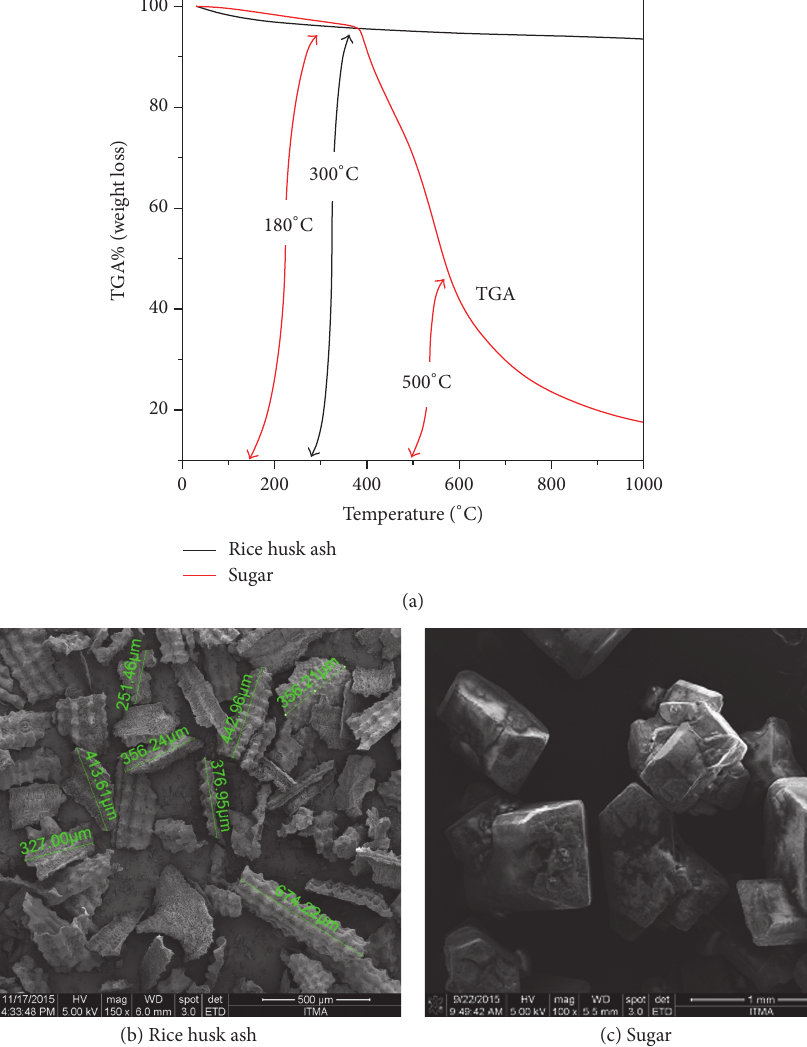
Figure 2: (a) TGA, (b) FESEM images of the rice husk ash, and (c) sucrose.